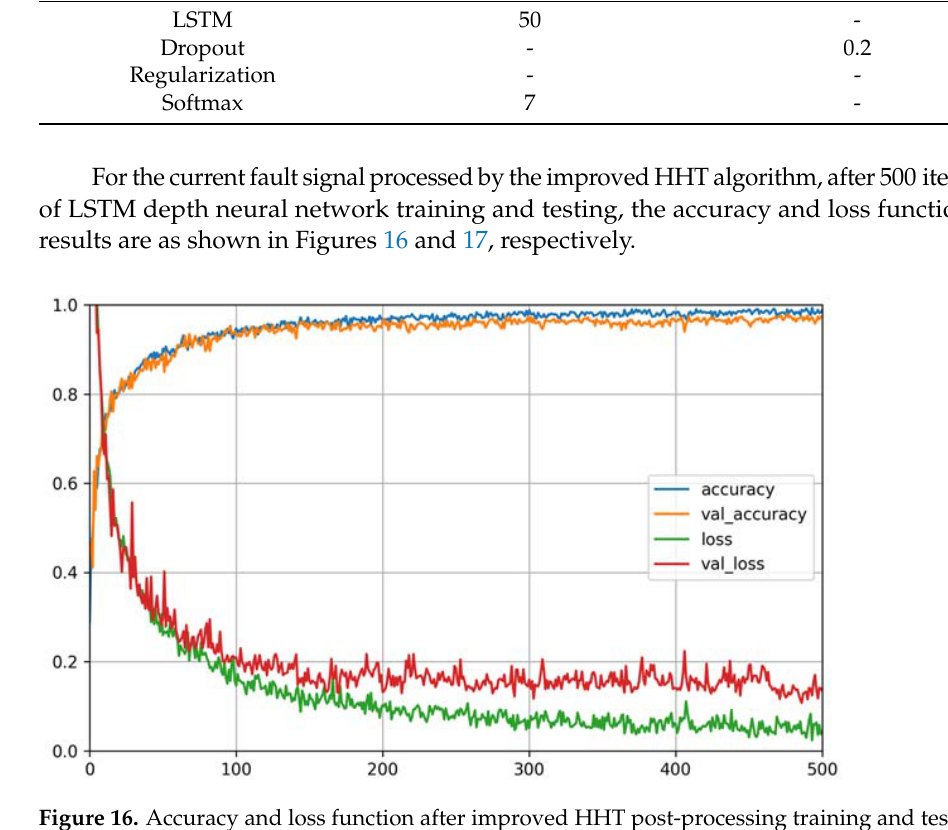
Figure 16. Accuracy and loss function after improved HHT post ‐ processing training and testing.